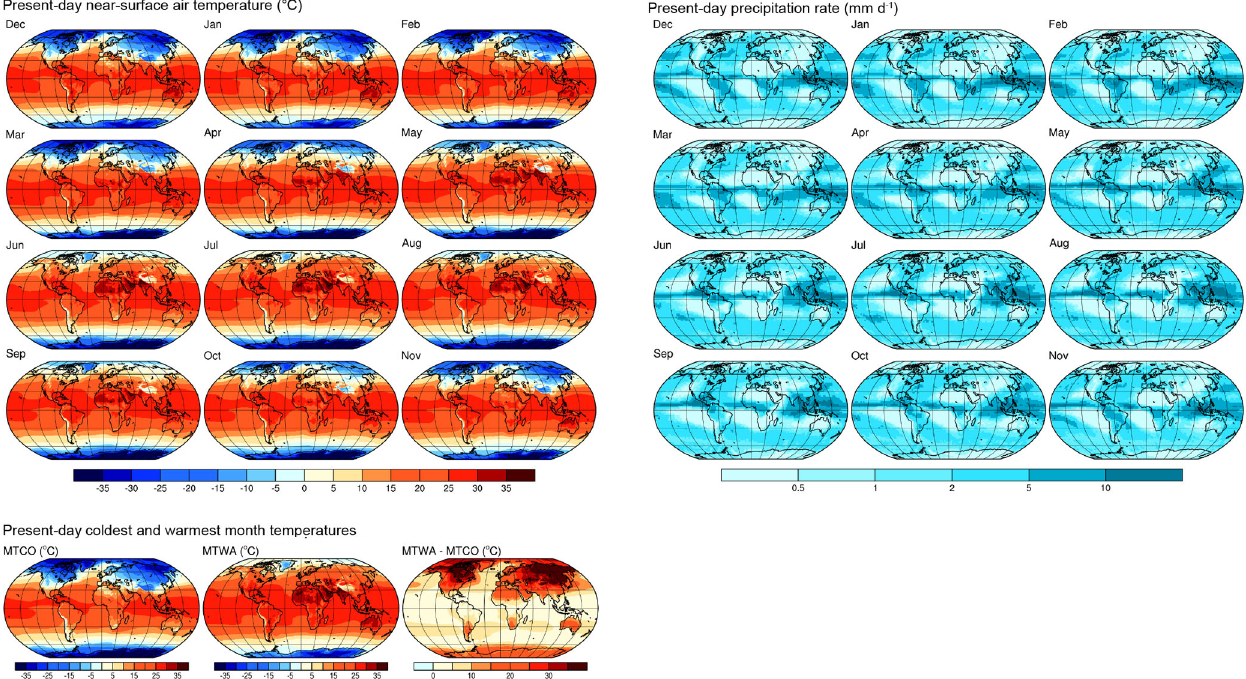
Figure 10. Present-day (1981–2010 CE) long-term mean values of monthly near-surface air temperature ( tas ) from the Climate Forecast System Reanalysis (CFSR), the mean temperatures of the warmest (MTWA) and coldest (MTCO) months and their differences from the same data, and precipitation rate ( precip ) from the CPC Merged Analysis of Precipitation